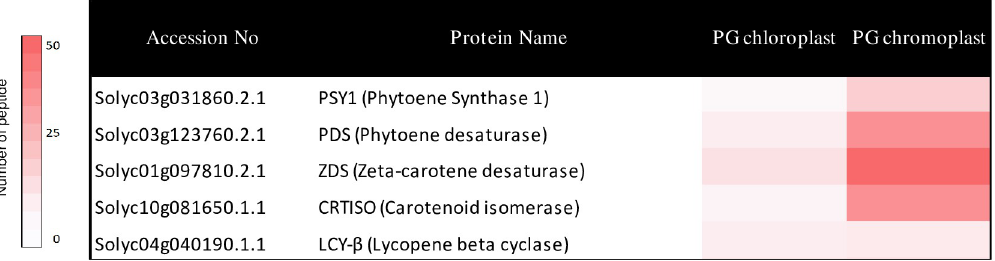
Fig 3. Carotenoid biosynthetic enzymes enriched in tomato PG chromoplasts. The carotenoid biosynthetic enzymes heatmap was generated from peptide counts obtained from PG isolated from chloroplasts and chromoplasts, respectively.